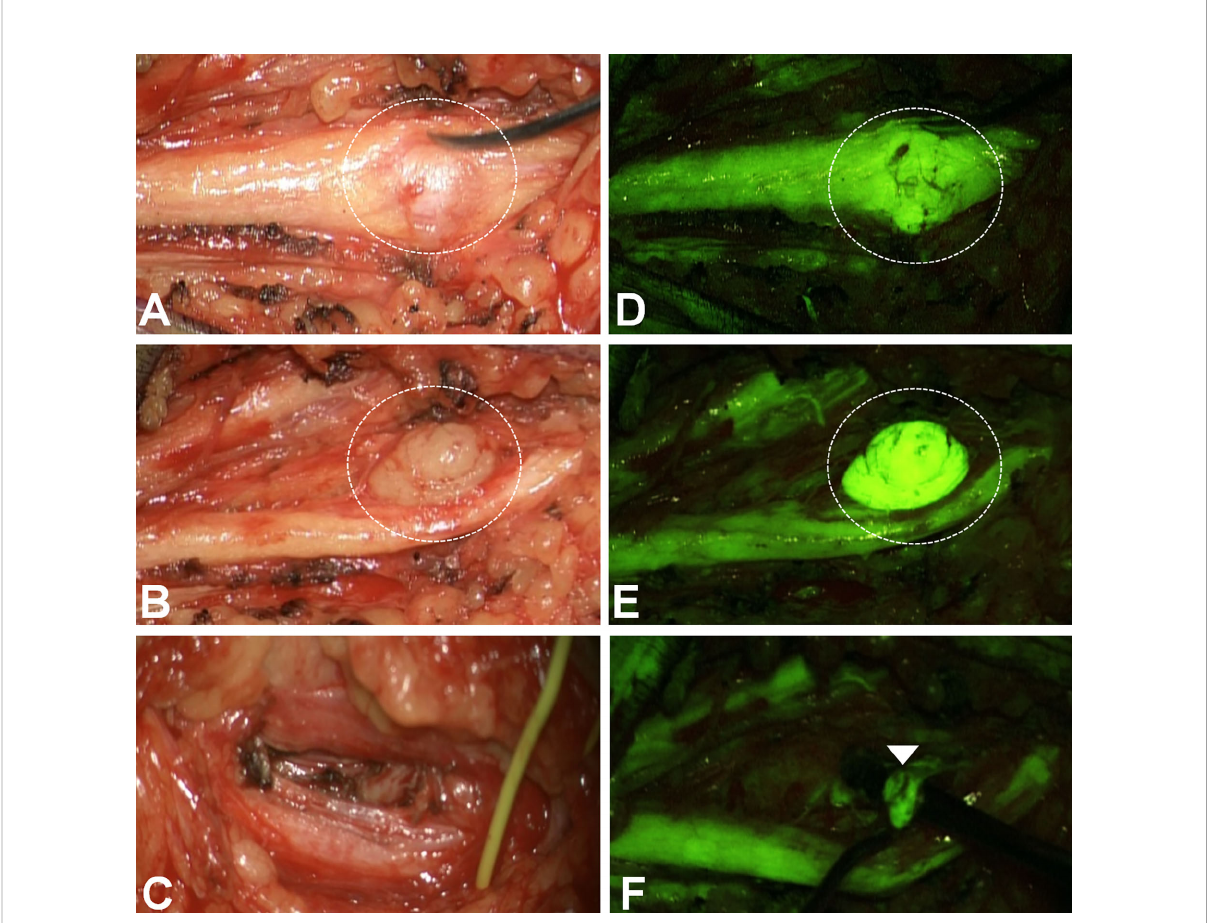
FIGURE 2 Remnants identi fi cation in a left super fi cial peroneal schwannoma ( A – C : white light; D – F : YELLOW560). After the popliteal fascia opening, the sciatic-super fi cial popliteal nerve was identi fi ed and followed distally: one 1,5 cm schwannoma was visible ( dotted circle in A). The fi rst fl uorescein examination (D) depicted a corresponding area of more slight fl uorescence than the nerve. Therefore the capsule was opened (B) . However, the tumor appeared intensely fl uorescent, more than the nerve (E) . After tumor removal (C) , the last examination under YELLOW560 evidenced a small remnant ( arrowhead ) non-clearly visible under white light, then removed to obtain a gross-total resection.